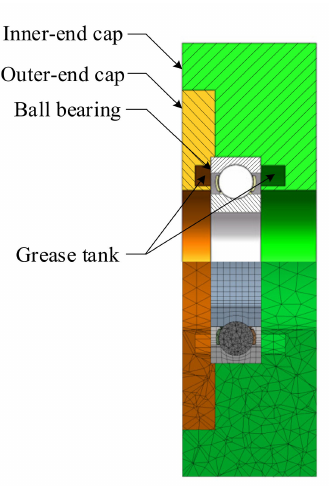
Figure 1. 3D section and mesh division of a transient bearing temperature solution